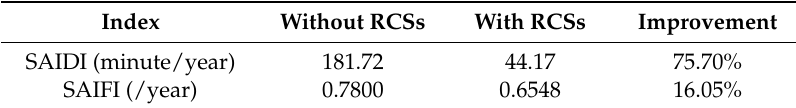
Table 3. Reliability improvement from installing